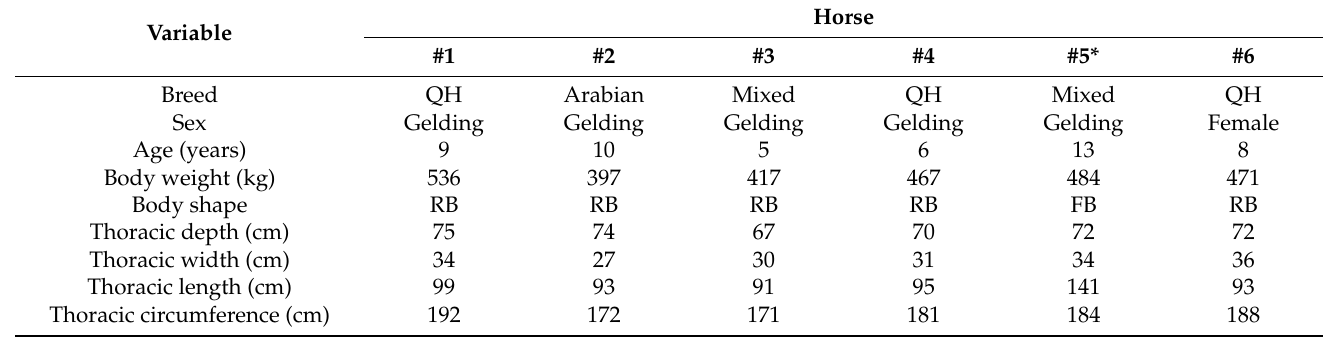
For breed, QH = Quarter Horse; For body shape, RB = Round-bellied and FB = Flat-bellied. Thoracic dimensions were obtained as previously described [12]. Depth = vertical distance between dorsal spinous processes and sternum; Width = horizontal depth between points of shoulder (scapulohumeral joint); Length = diagonal from point of shoulder to distal end of last rib; Circumference = caudal to withers. * = Horse #5 was considered an outlier based on body shape and thoracic